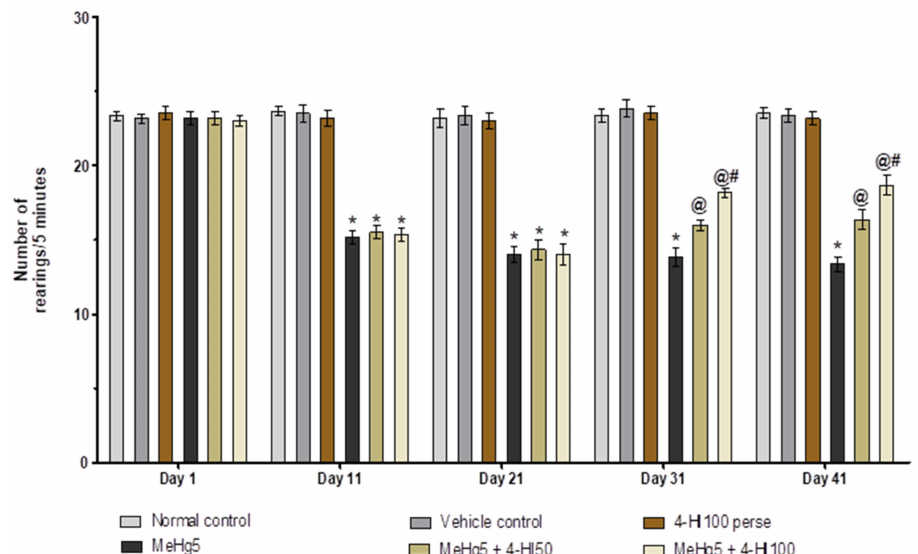
Figure 6. Effect of 4-hydroxyisoleucine on anxiety-like behaviour (number of rearing) after methyl mercuryexposure in rats.Statistical analysis by two-way ANOVA (posthoc Bonferroni’s test). Values are expressed as mean ± SEM ( n = 6 rats per group). * p < 0.001 v/s normal control, vehicle control and 4-HI100 perse ; @ p < 0.001 v/s MeHg5; @# p < 0.001 v/s MeHg5 + 4-HI50.